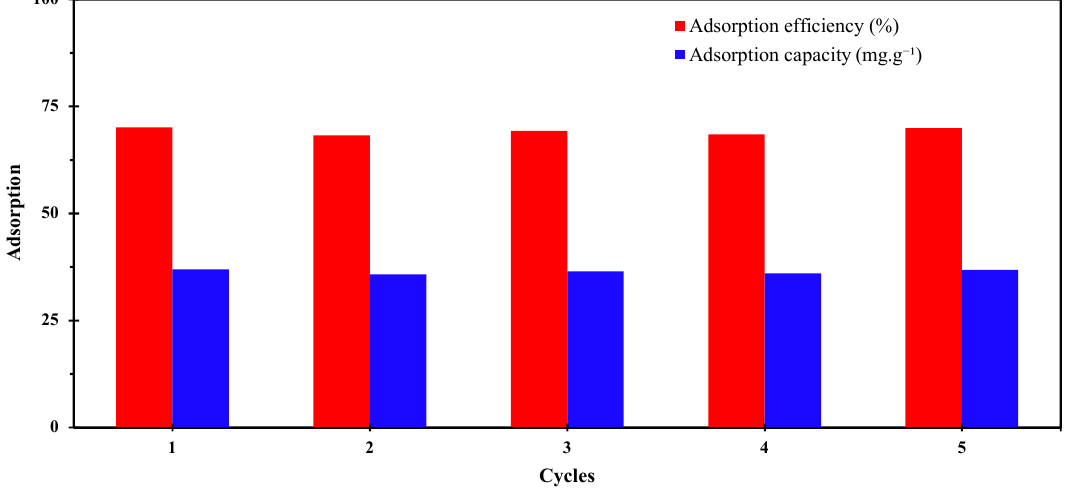
Figure 6. Stability test of heparin recovery over ZIF-8.